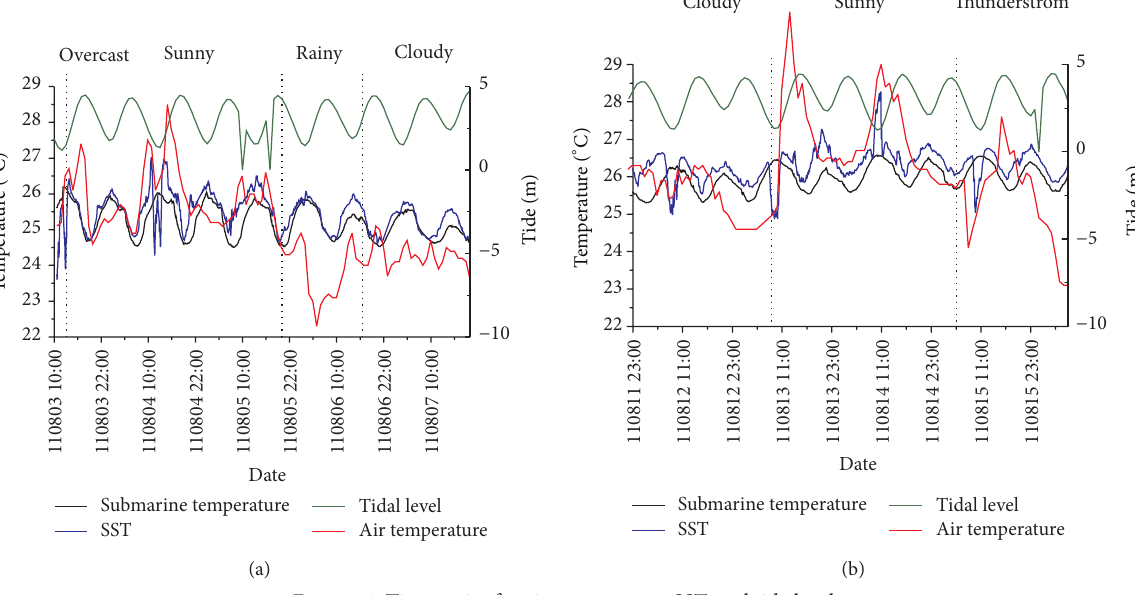
Figure 4: Time series for air temperature, SST, and tide